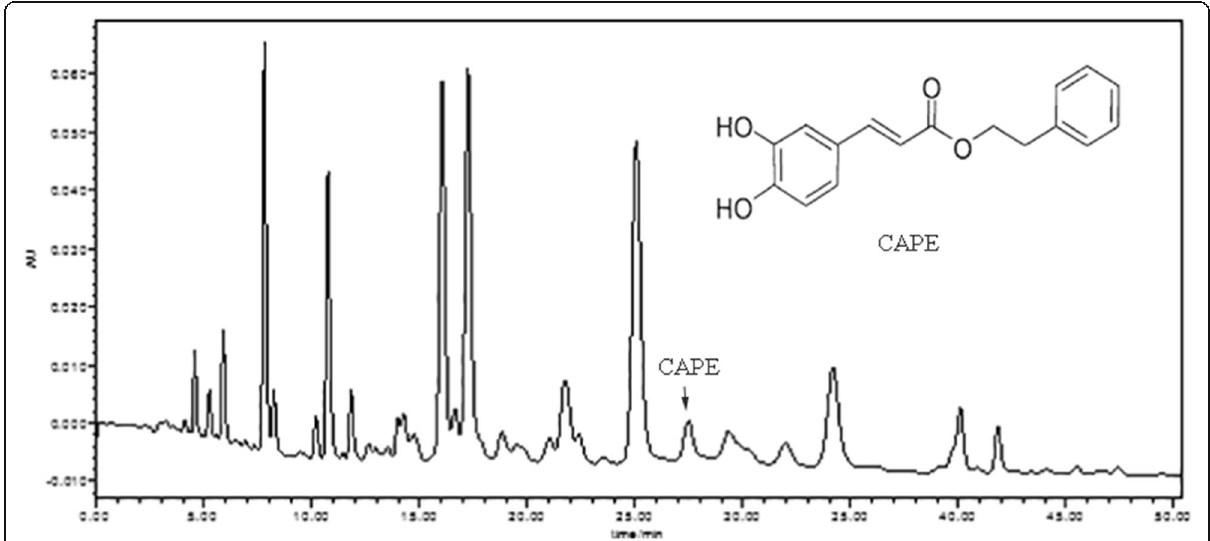
Fig. 1 HPLC chromatograms of ethanol-extracted Chinese propolis (EECP) and caffeic acid phenethyl ester (CAPE)